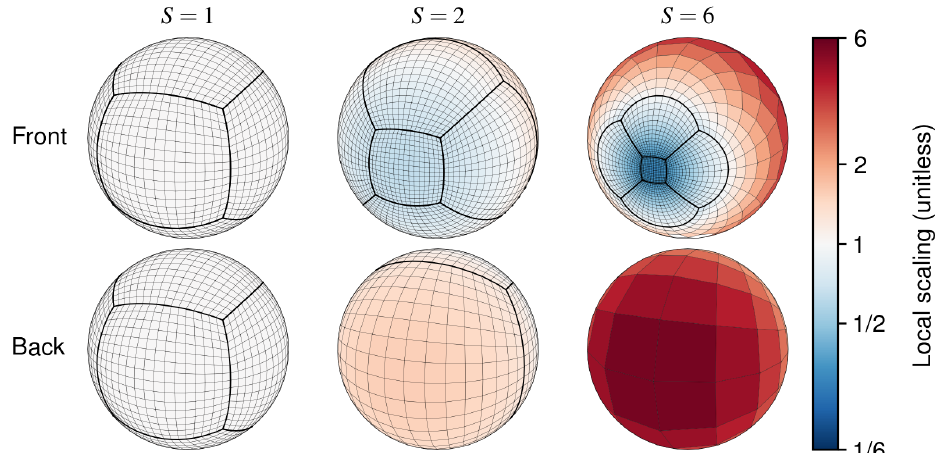
Figure 2. Three stretched grids that illustrate the effect of the stretch factor ( S ) on stretching a C16 cubed sphere. Local scaling is the relative change to a grid box’s edge length induced by stretching.